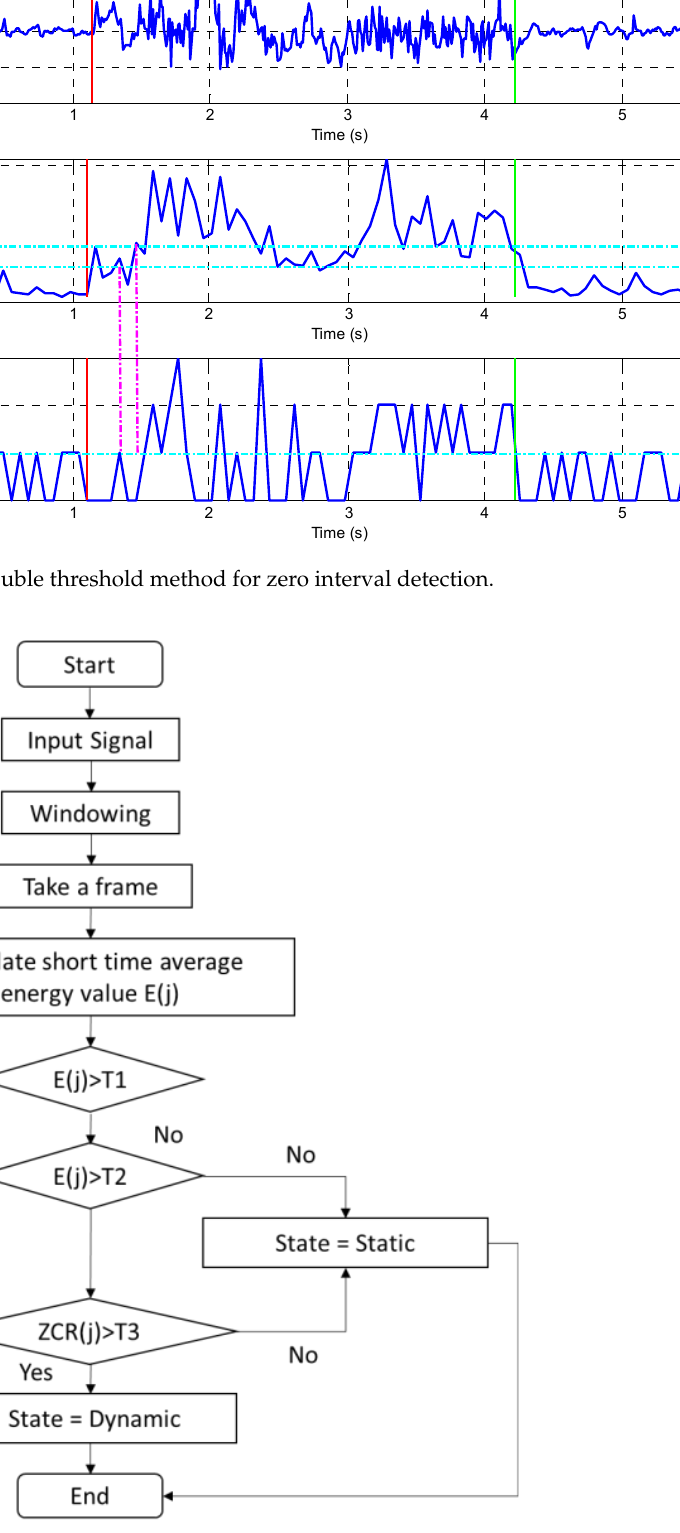
Figure 8. Double threshold method for zero interval detection in nine-hole peg test. 3.2. Wavelet Analysis The basis of the wavelet analysis is to decompose a signal (a time-series) into different scale components using wavelets. Fourier analysis deals with the reconstruction of the signal by sinusoidal components whereas the wavelet analysis does this in terms of wave- lets. Wavelet analysis can decompose a signal into the optimal approximation (low-fre- quency part) and high-frequency part with detailed information [49]. Multiple-level de- composition is used. After decomposition, reconstruction of the signal is the process of assembling all the frequency components except for the low-frequency part. The wavelet transforms the signal 𝑠(𝑡) with respect to the wavelet function 𝜓(𝑡) as defined in Equation (7): 1